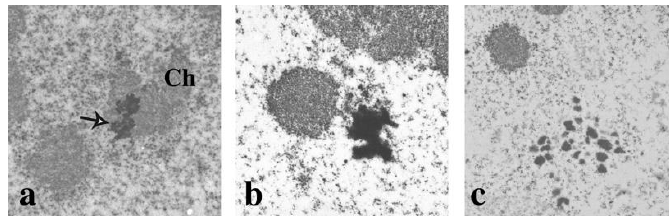
Figure 7. Electron microscopy analysis of mitotic cells harvested after heat shock. HeLa cells were heat shocked and allowed to recover at 37 °C for 3 h and then incubated for 18 h in the presence of nocodazole (80 ng/mL). Cells were analyzed using electron microscopy as previously described. Ch: chromatin. Arrow in panel ( a ) points to clusters of perichromatin granules embedded in chromatin. In panel ( b ) chromatin protrusions are visible linking the chromatin mass to clusters of perichromatin granules. Dispersed perichromatin granules are visible in panel ( c ).